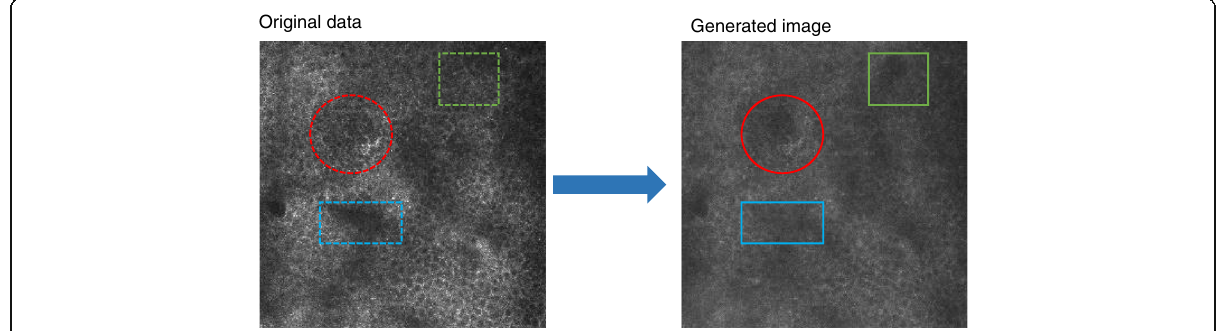
Fig. 6 Generation of the original images without demodicosis based on small sample. This shows the effect of the picture without the demodicosis. The generated data has data that is very similar to the original data, as well as different